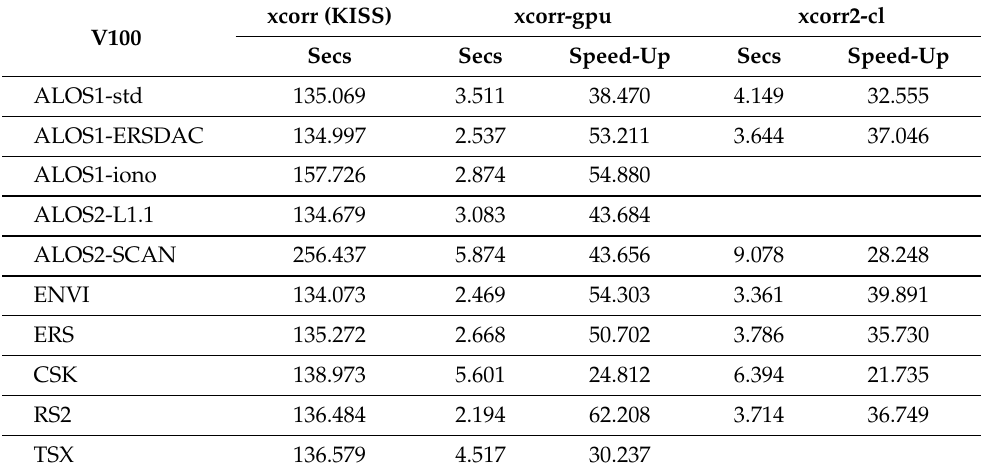
Table 4. Execution times and Speed-Up for xcorr , xcorr-gpu , xcorr2-cl on V100 hardware configuration.